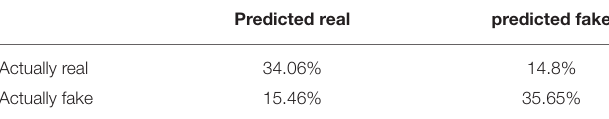
TABLE 4 | Confusion matrix for